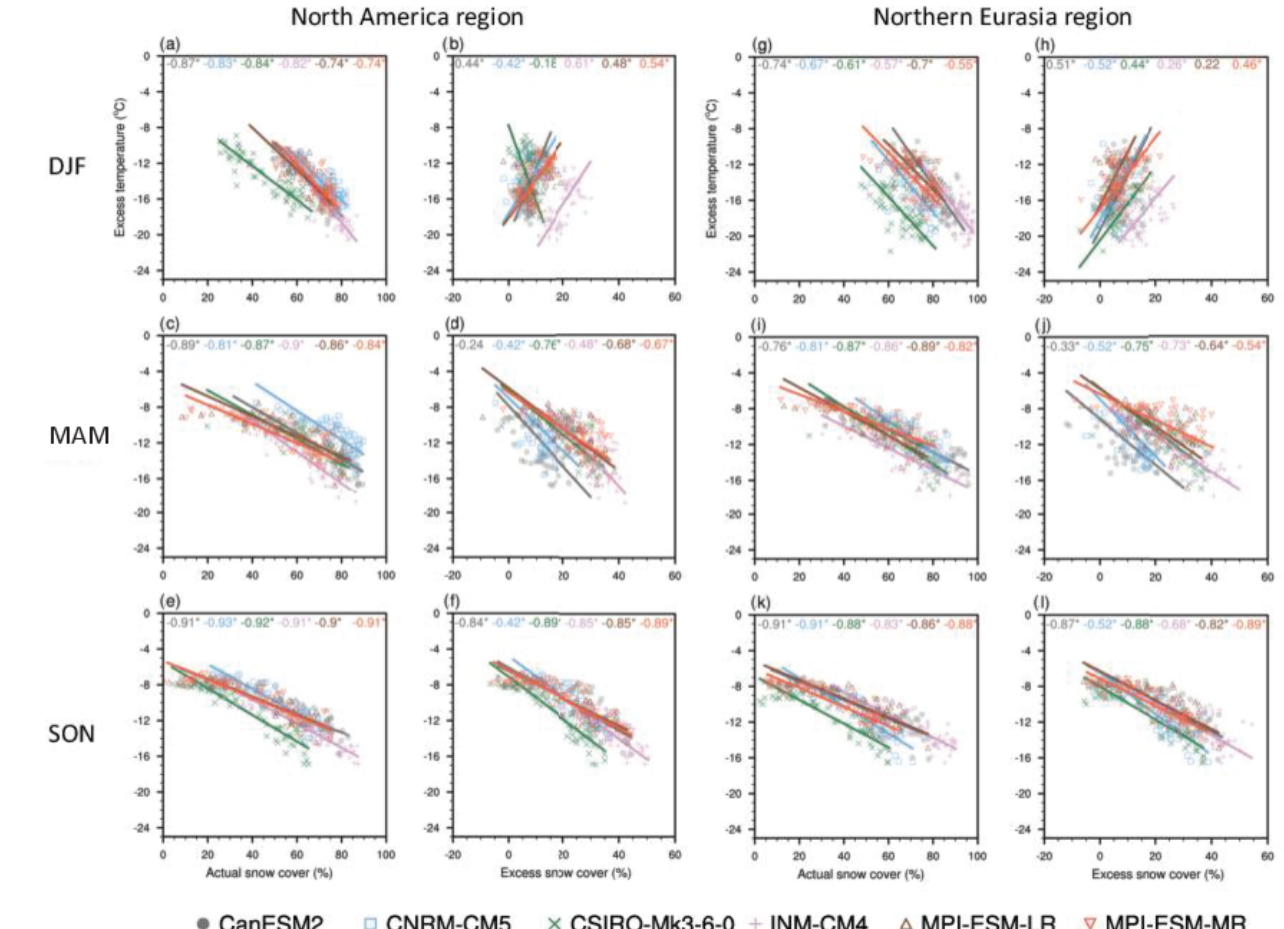
Figure 4. Scatter plots showing annual values of excess temperatures in cold extremes for each season on the y axis, and annual values in each season of actual snow cover (snow cover values on the day the cold extreme occurs) on the x axis (a, c, e, g, i, k) . Panels (b, d, f, h, j, l) show values of excess snow cover on the x axis (i.e. snow cover on the day of the extreme – mean seasonal snow cover). Each row represents a different season: boreal winter (DJF) (a, b, g, h) , spring (MAM) in (c, d, i, j) and autumn (SON) in (e, f, k, l) . Each point is an area average of two regions (see Fig. S2): North America (a–f) and northern Eurasia (g–l) . The straight lines indicate the regression slope for each model calculated using total least squares regression. Correlation coefficients are shown at the top of each panel, with the different colours indicating the model. The asterisk ∗ indicates significance at the 5%